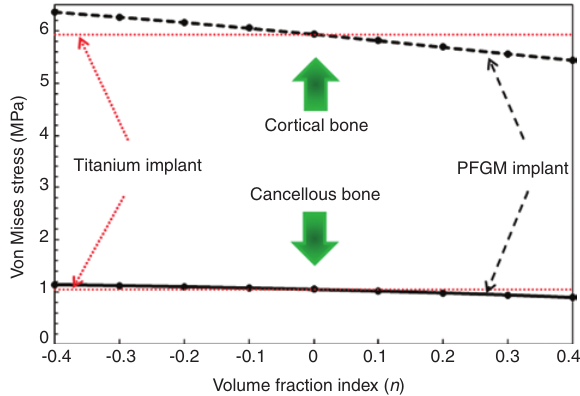
Table 1: Material properties in the simulation models.